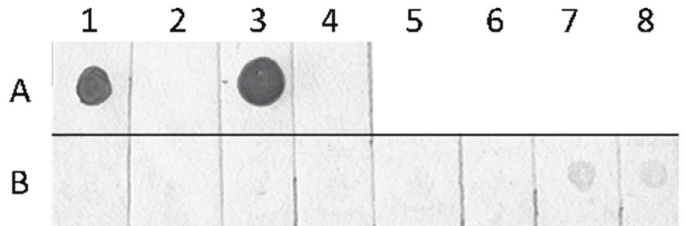
Figure 1. Immuno-dot blot using antibody specific for 5-methylcytosine. Lane A represents 100 ng of methylated DNA from the plasmid pUC (A1), 100 ng of unmethylated DNA from pUC (A2), 625 ng of human genomic DNA (A3), 250 ng of 5-hydroxymethylated DNA from Staphylococcus aureus (A4) . Lane B—200 ng of genomic DNAs from D. pulex juveniles (B1, B2), preadults (B3, B4), adults I (B5, B6), and adults II (B7, B8); even numbers—individuals hatched form parthenogenetic eggs; odd